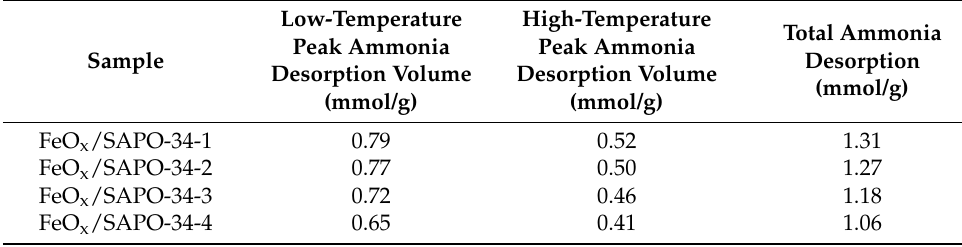
Table 2. Calculation of acid quantity for the FeO x /SAPO-34 molecular sieve samples.